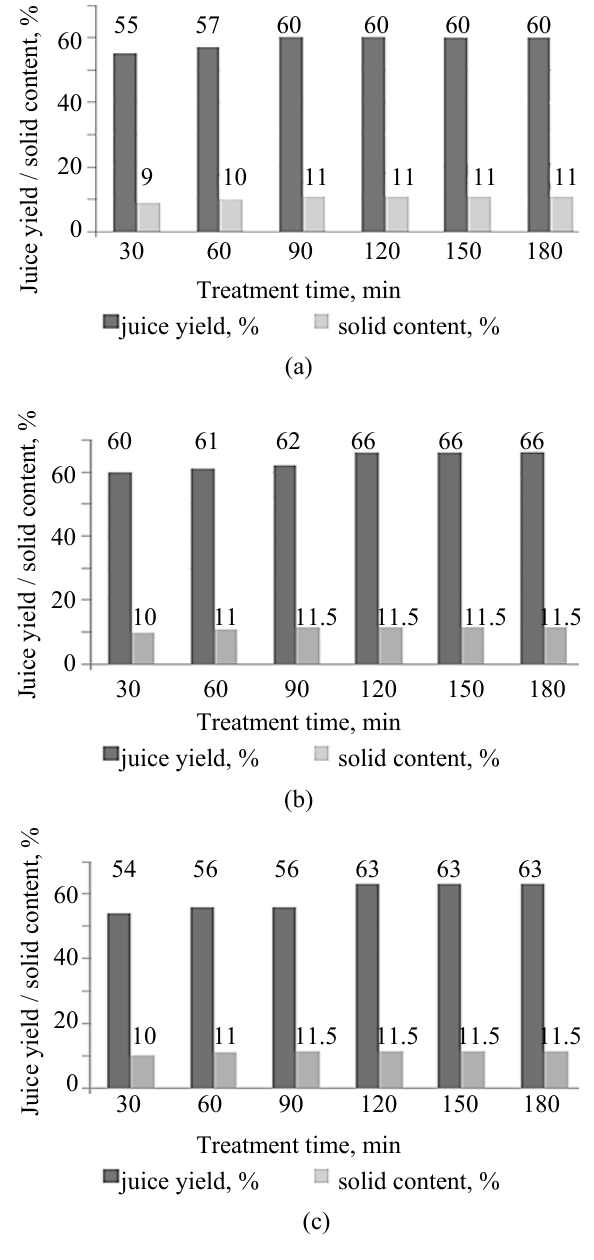
Fig. 7. Dynamics of juice yield and solids content during the maceration of pulp of different varieties of carrots using a Fructozym Color enzymatic preparation in an amount of 0.01% of the mass, T = 55°C: (a) Nantes variety carrots, (b) Forto variety carrots, and (c) Toucheon variety carrots. Table 7. Antioxidant activity of carrots before and after maceration Total Variety of carrots